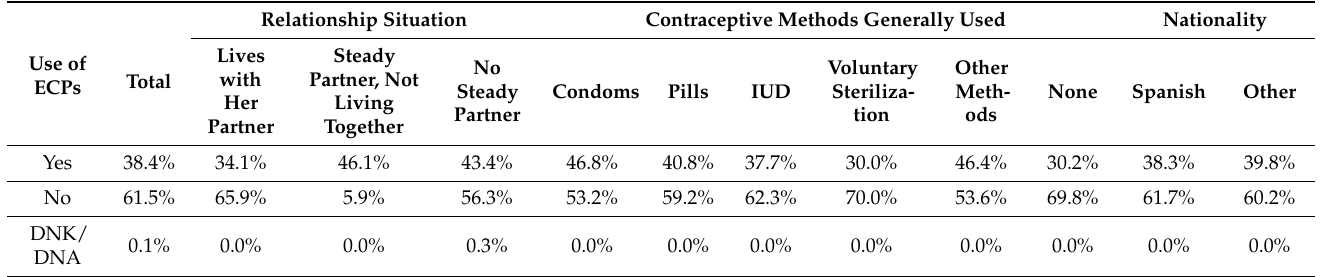
Table 2. Table 2. Use of Emergency Contraception Pills (ECPs) over lifetime according to usual contraceptive method, nationality and relationship status.